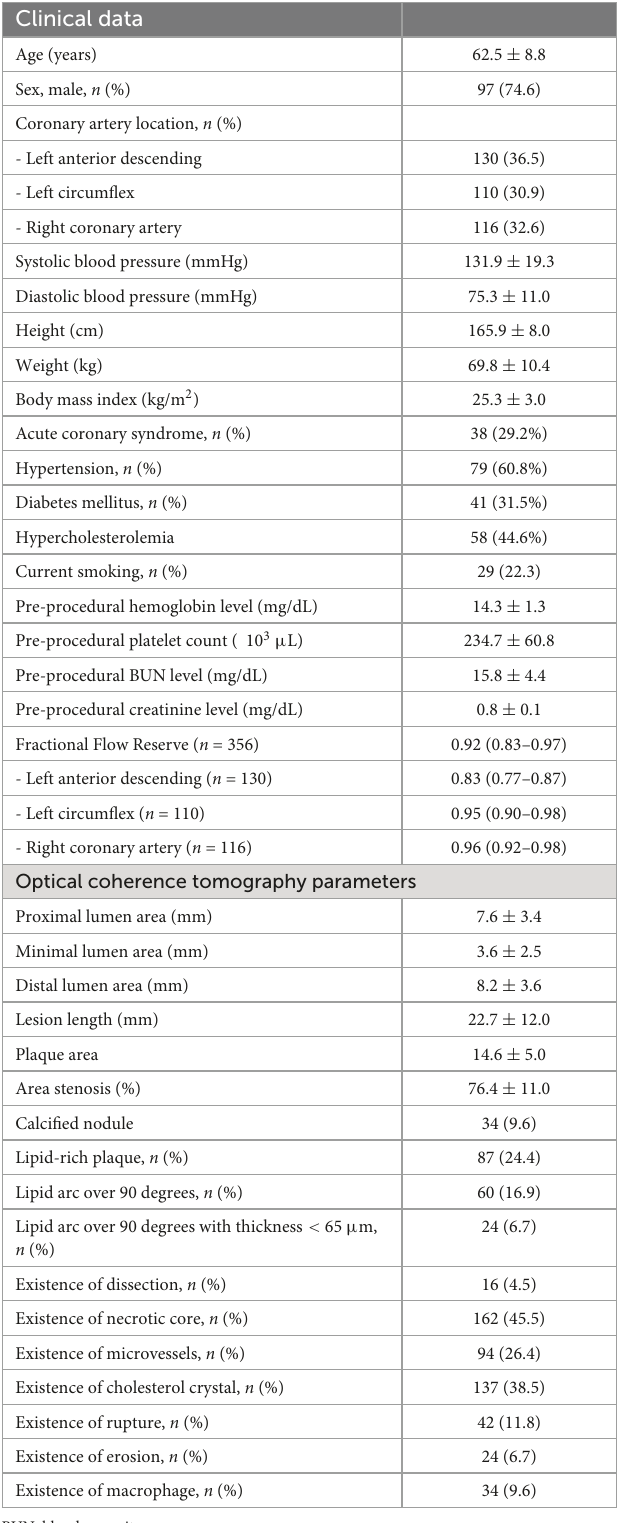
TABLE 1 Baseline characteristics of 130 patients with 356 coronary lesions. Clinical